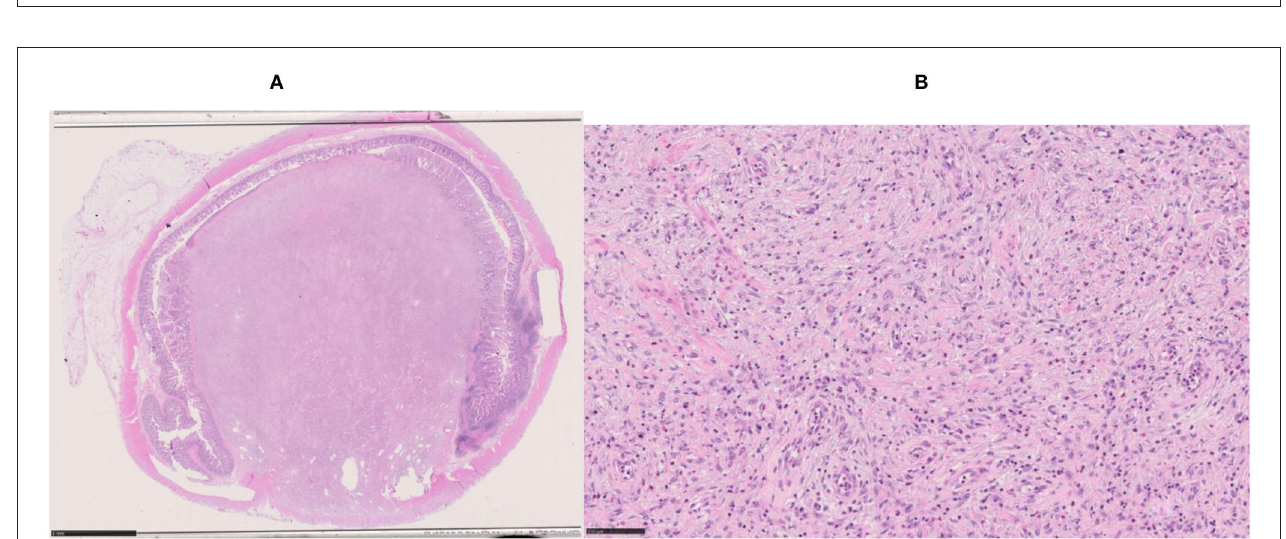
FIGURE 5 | Microscopic view of the inflammatory fibroid polyp. (A) Whole-mount section showing complete obstruction of the lumen (Hematoxylin & Eosin, i.o. x1; bar = 5mm). (B) Spindle cells with myofibroblast features admixed with inflammatory cells (Hematoxylin & Eosin, i.o. x20; bar = 100 micrometer).